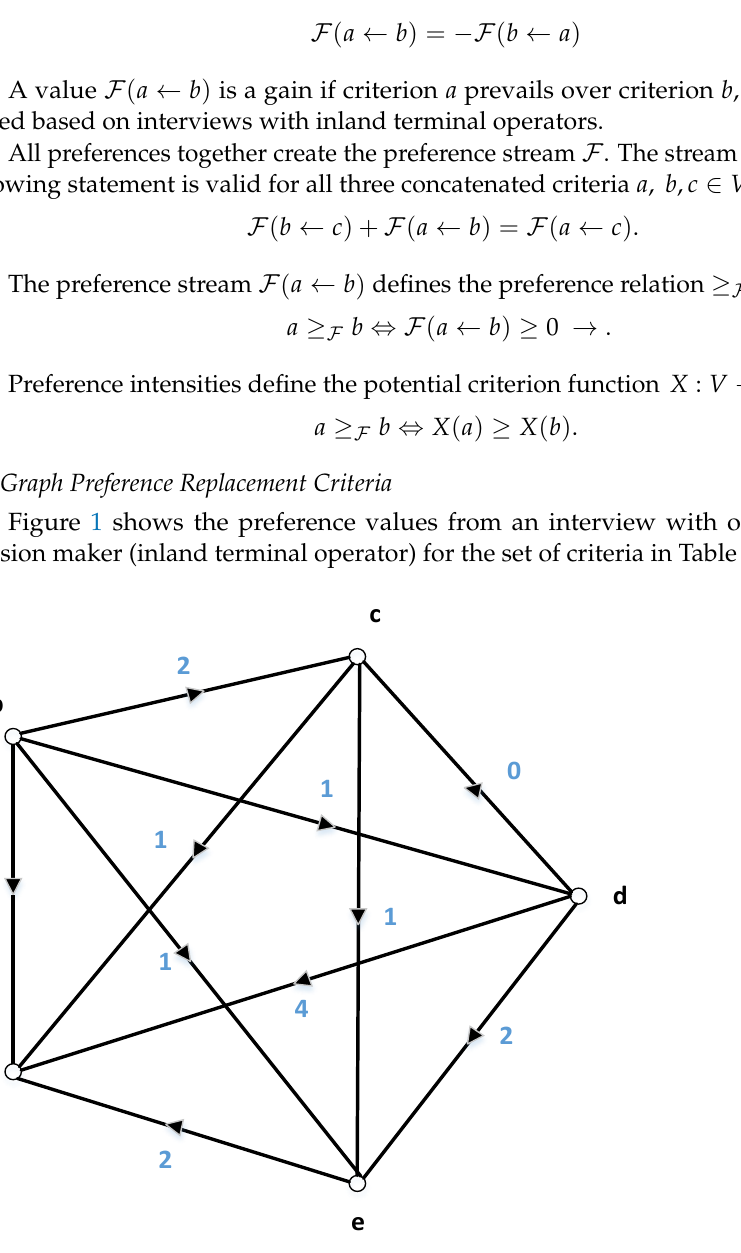
Figure 1. Preferences of the criteria for locating a container in the inbound zone of an inland terminal. The letters refer to criteria, and the numbers on the connecting lines refer to preferences (see Section 4.1).